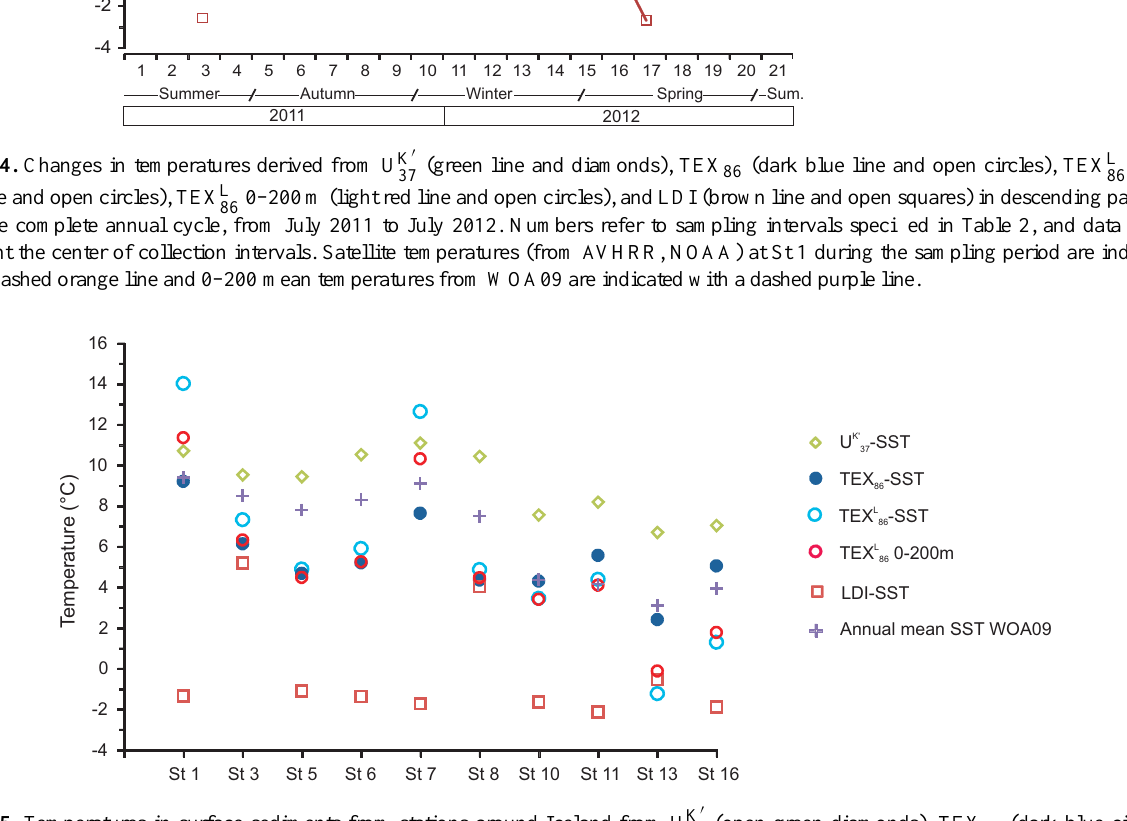
Figure 5. Temperatures in surface sediments from stations around Iceland from U K (open light blue circles), TEX L 0–200m (open red circles) and LDI (open brown squares) derived . Annual mean SSTs at each TEX L 86 86 station obtained from the WOA09 database are indicated as purple